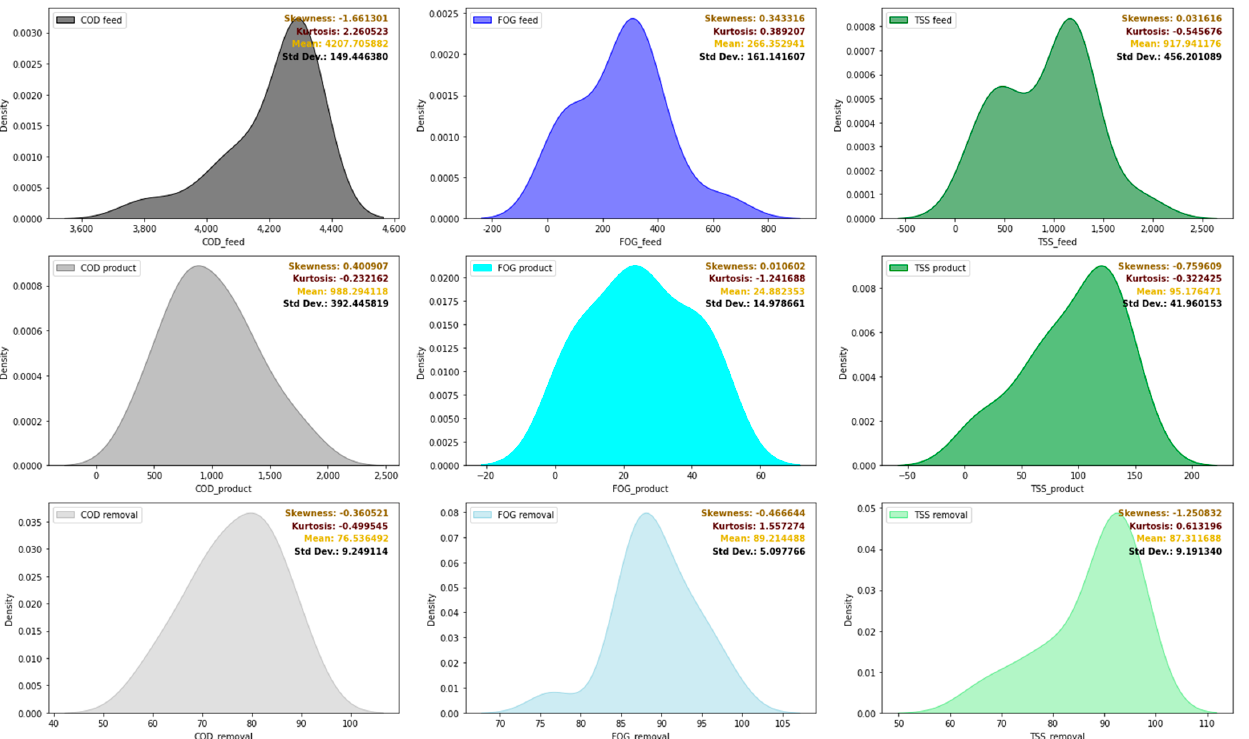
Figure 14. Probability density function of the inlet and outlet of the overall system, including their removal efficiencies.